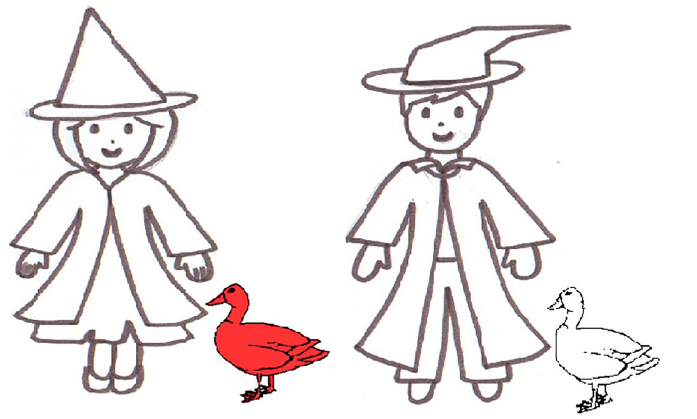
Fig 1. Example of a target